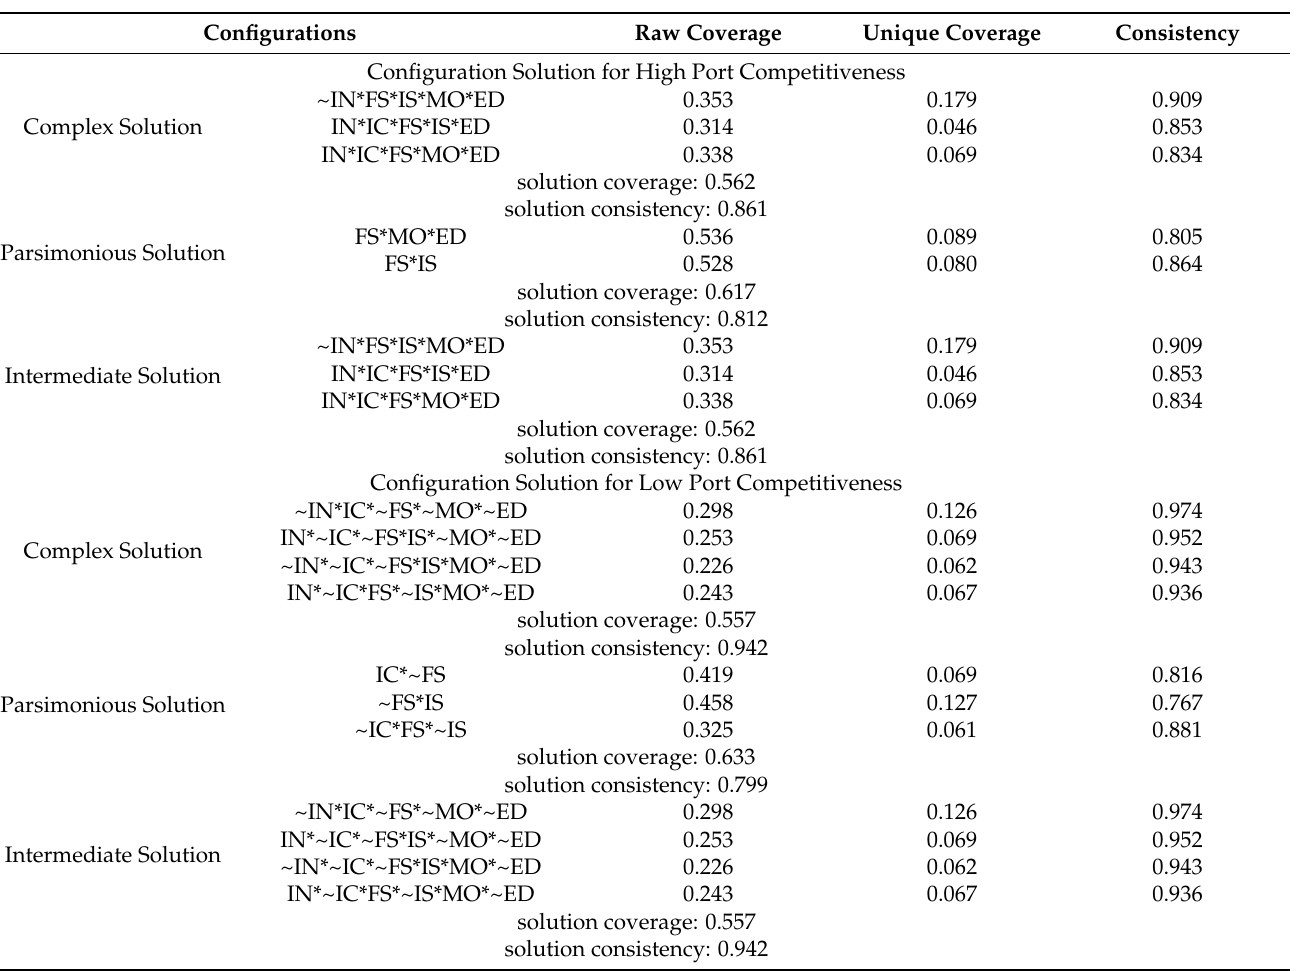
Table A1. Results of fsQCA of port